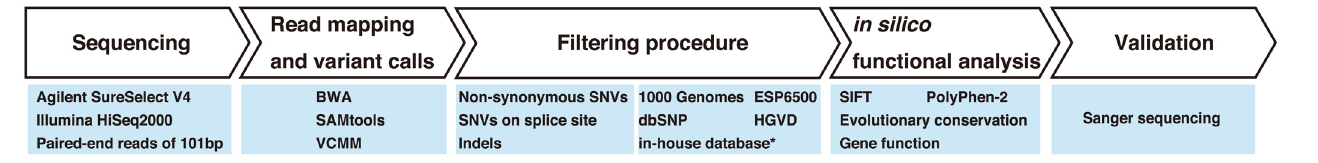
Fig 1. Experimental work flow for detecting sequence variants by WES. In-house database with asterisk is our in-house whole exome or whole genome data composed of 1,257 non-cardiac Japanese individuals.